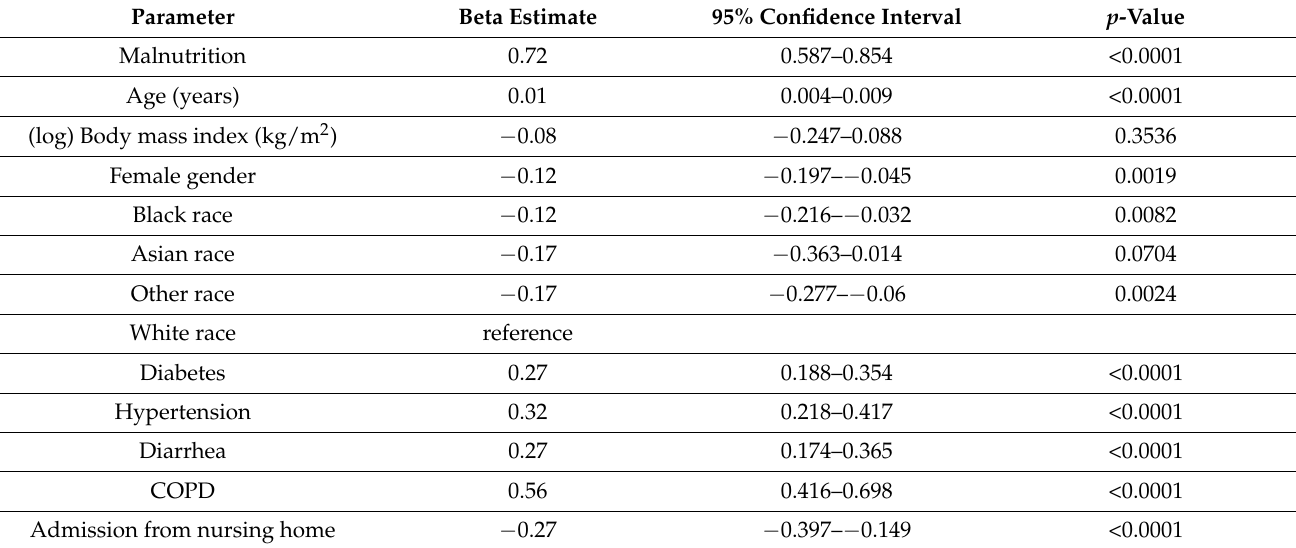
Table 4. Multivariable linear regression predicting (log) length of hospital stay (n =